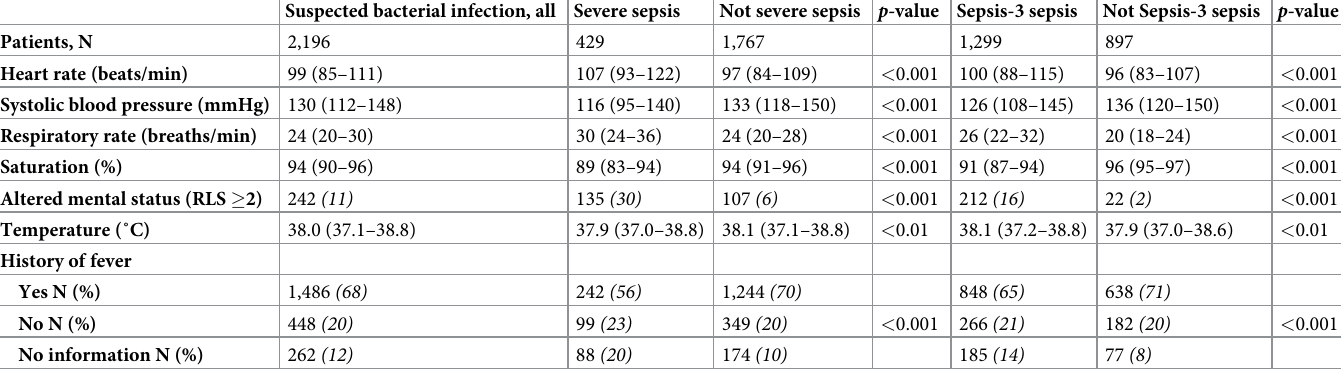
Table 2. Vital signs 1 at baseline in 2,196 consecutive adult patients with suspected community onset bacterial infection treated with intravenous antibiotics. Results are presented also for patients with severe sepsis and Sepsis-3 sepsis. Values listed are medians (IQR) for all but RLS where the number of patients with RLS � 2 are used. Suspected bacterial infection, all Severe sepsis Not severe sepsis p- value Sepsis-3 sepsis Not Sepsis-3 sepsis p-